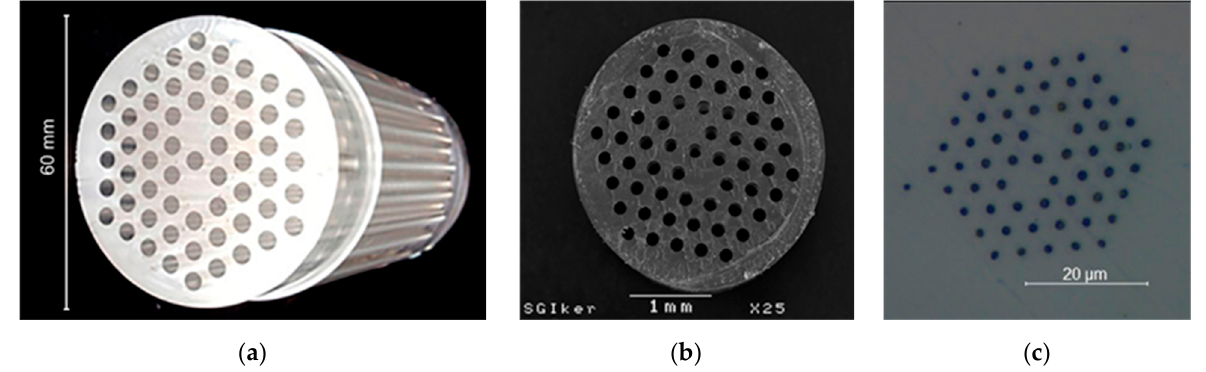
Figure 1. Photographs of ( a ) the fabricated PMMA preform, ( b ) the intermediate PMMA cane and ( c ) the cross-section of the final DC mMOF.